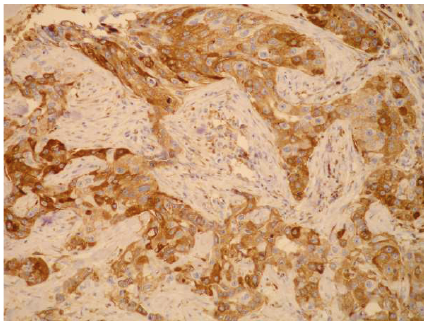
Figure 7: Change of the Sdc1 expression — from the strong epithelial Sdc1 expression to the moderate stromal Sdc1 expression, on the edge of the ductal carcinoma metastasis in the axillary node (subcapsular) (IHC, ×